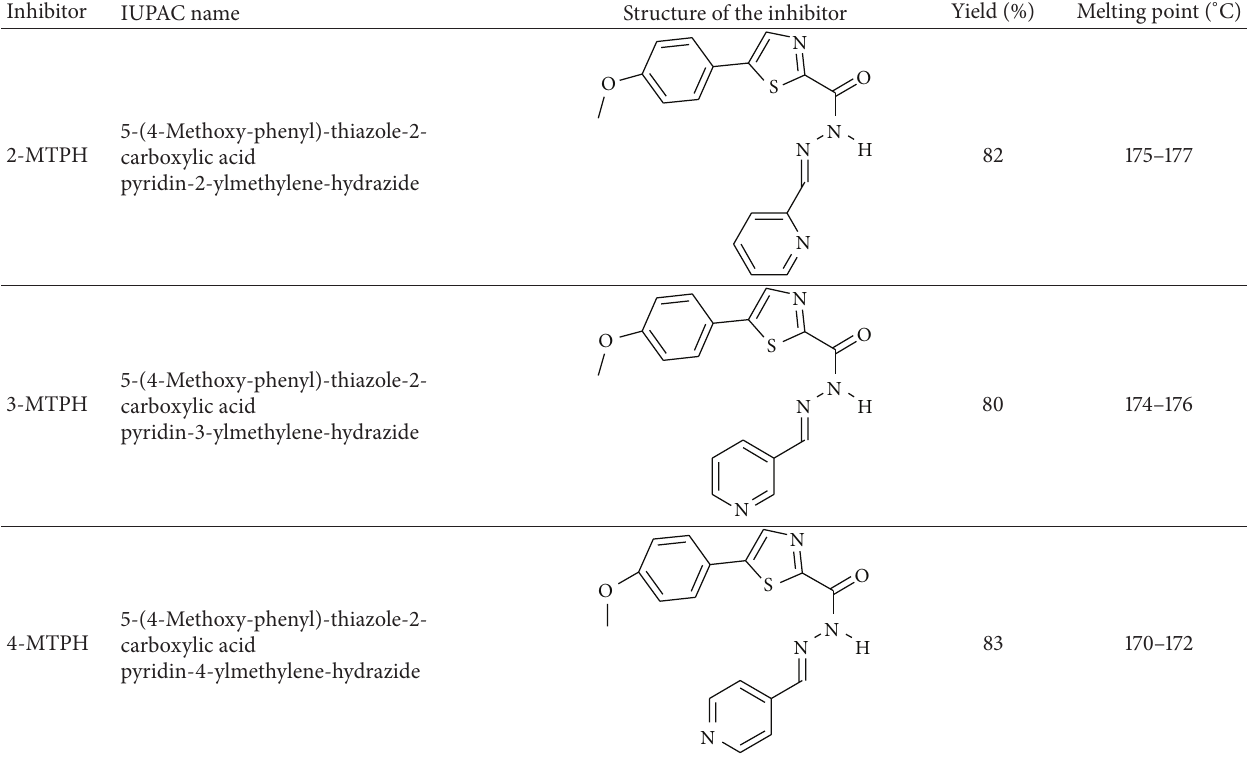
Table 1: Abbreviations, IUPAC names, molecular structure, and melting points of